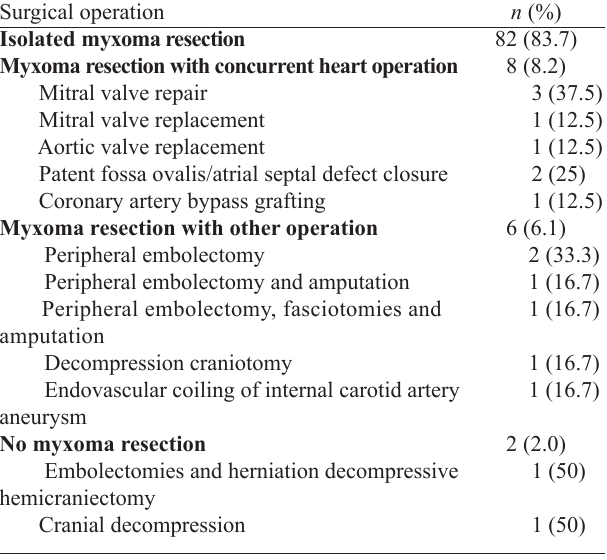
Table 11. Surgical operations in 98 patients with cardiac myxoma